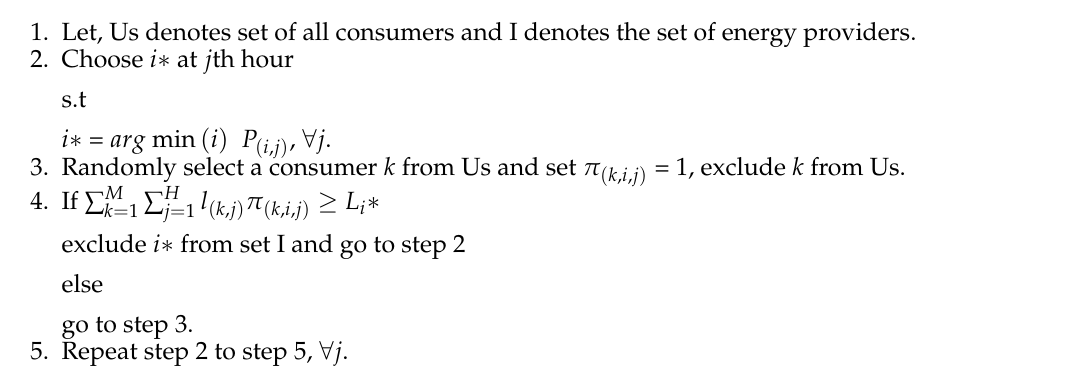
Algorithm 1 Suboptimal scheme for sum cost